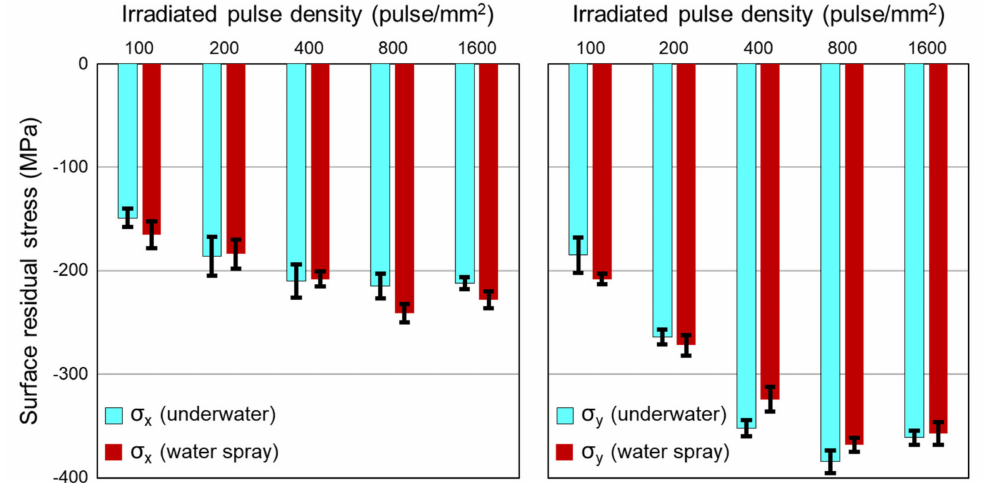
Figure 5. Surface RSs on A7075-T73 after LPwC (pulse energy 1.7 mJ). Blue and red bars: RSs induced by the underwater and water spray modes, respectively. The RSs in the X- and Y-directions are displayed on the left and right, respectively.